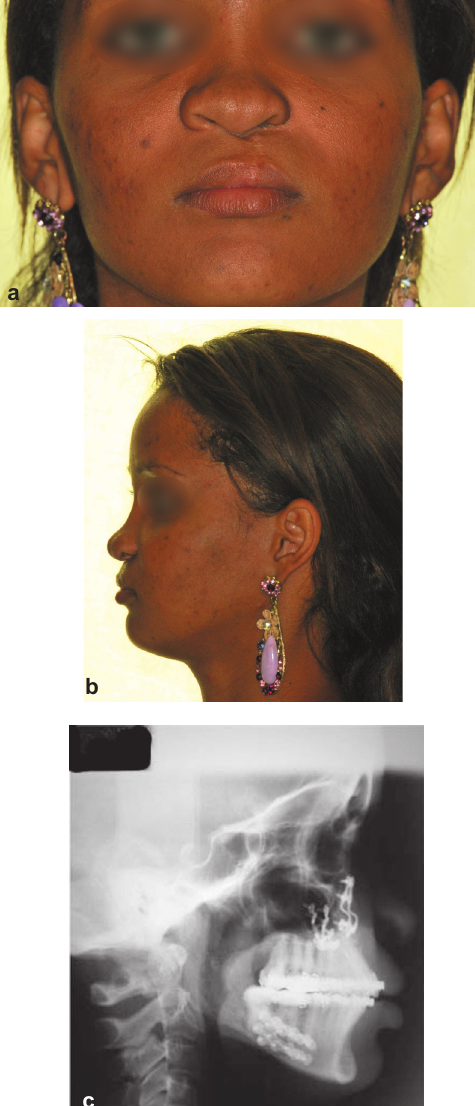
Figure 10- Le Fort I osteotomy with maxillary advancement was performed. Postoperative photographs are shown (a) facial frontal view (b) facial lateral view (c) post-surgical cephalometric radiography